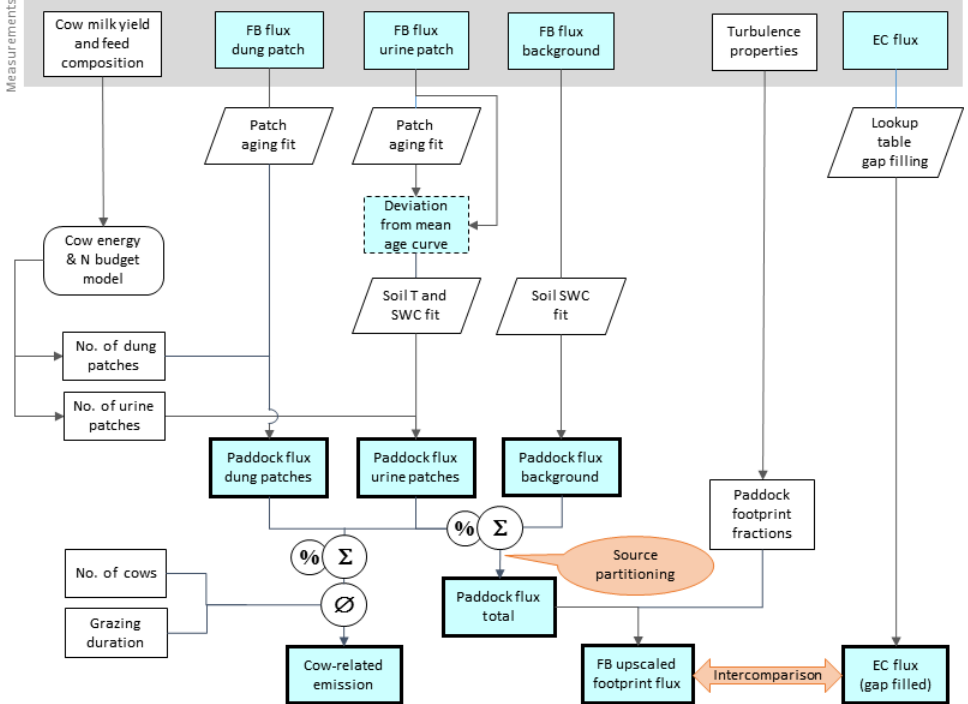
Figure 5. Flowchart of upscaling procedure to compare small-scale chamber fluxes with EC fluxes and to estimate the contribution of excreta emissions to the overall pasture emission. Rectangular shapes indicate time series data and other data sets. Time series data with thin frames have gaps whereas bold frames indicate complete data sets. The light blue color specifies N 2 O flux data. Other shapes show operations (e.g., fit or gap-filling